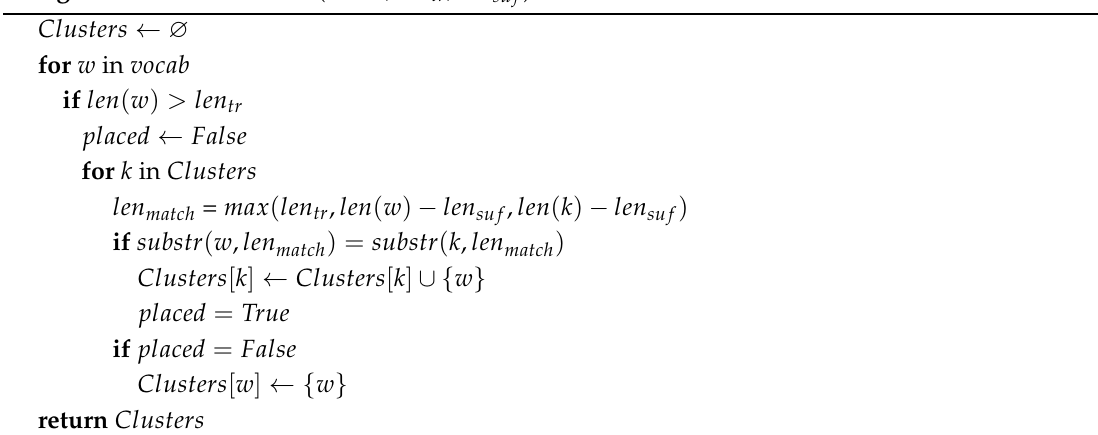
Algorithm 1: ClusterForms ( vocab , len tr , len suf )